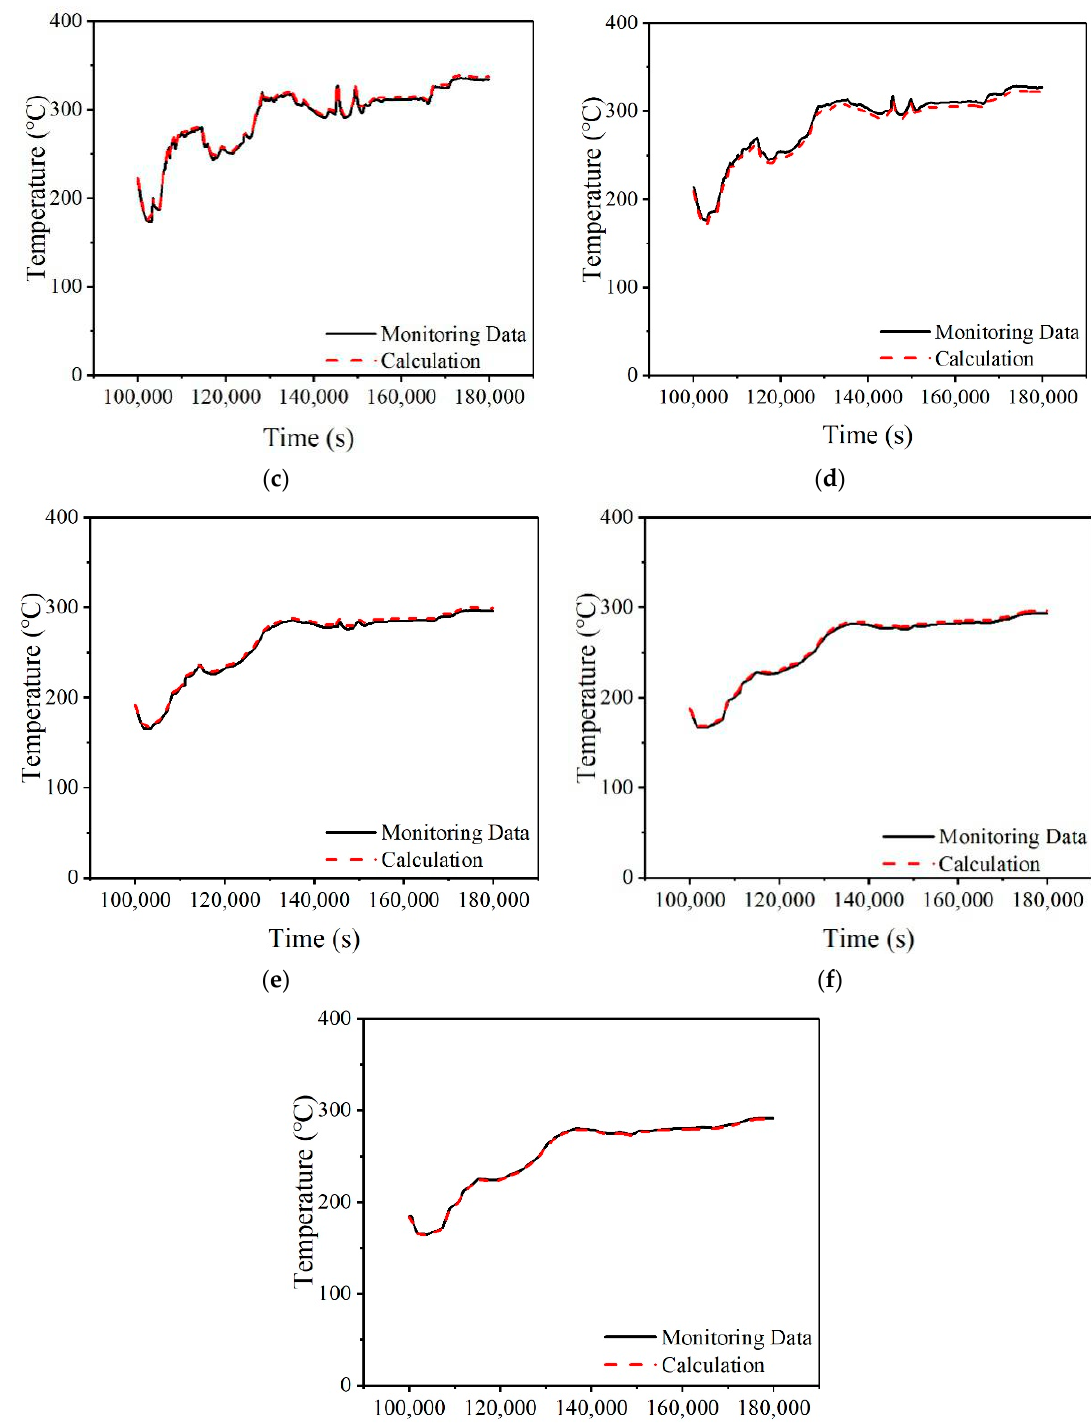
Figure 24. The comparison of the calculation result for the heat flux of the linear distribution law with the temperature of the monitoring points. ( a ) Monitoring Point 31. ( b ) Monitoring Point 32. ( c ) Monitoring Point 33. ( d ) Monitoring Point 34. ( e ) Monitoring Point 35. ( f ) Monitoring Point 36. ( g ) Monitoring Point 37.